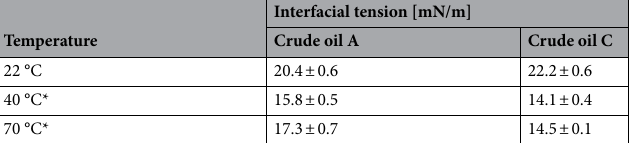
Interfacial tension